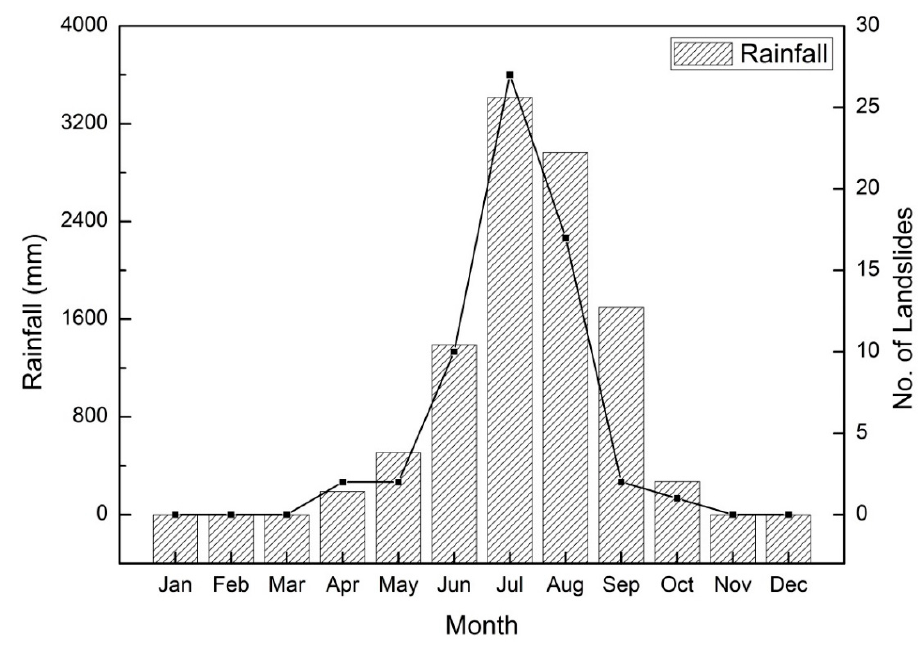
Figure 3. The variation of monthly rainfall and landslide occurrence from 2010 to 2016.